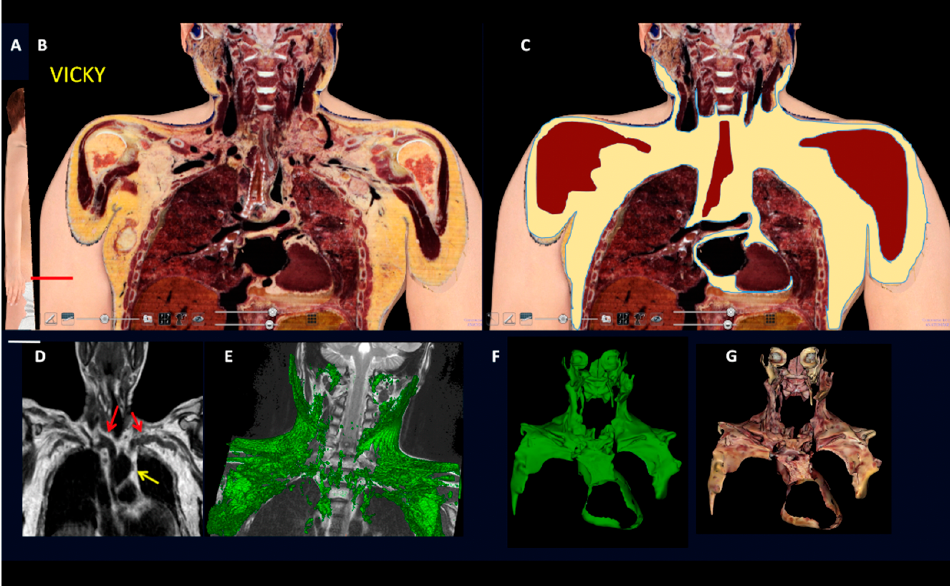
Figure 4. Gross anatomy and MRI of subcutaneous-visceral continuity in human Adipose Organ. ( A ): Oblique frontal section of a digital cadaver (Vicky). ( B ): Supraclavicular-mediastinal continuity of the section shown in ( A ). ( C ): The same section shown in ( B ), with the fat area highlighted in yellow. ( D ): Routine MRI in an adult male. Red arrows indicate subcutaneous-visceral fat connection (SVC) and the yellow arrow indicates the mediastinal fat. ( E ): 3D rendering (green) of the SVC in a 10-year-old boy. ( F , G ): 3D reconstruction of the fat present in the supraclavicular-mediastinal continuity shown in ( B , C ). Fat area is highlighted in three planes (axial, coronal, and sagittal); in F fat is in green for comparison with ( E ); in ( G ) fat is shown in its original colors. Bar: 60 mm in ( B , C ), 45 mm in ( F , G ).